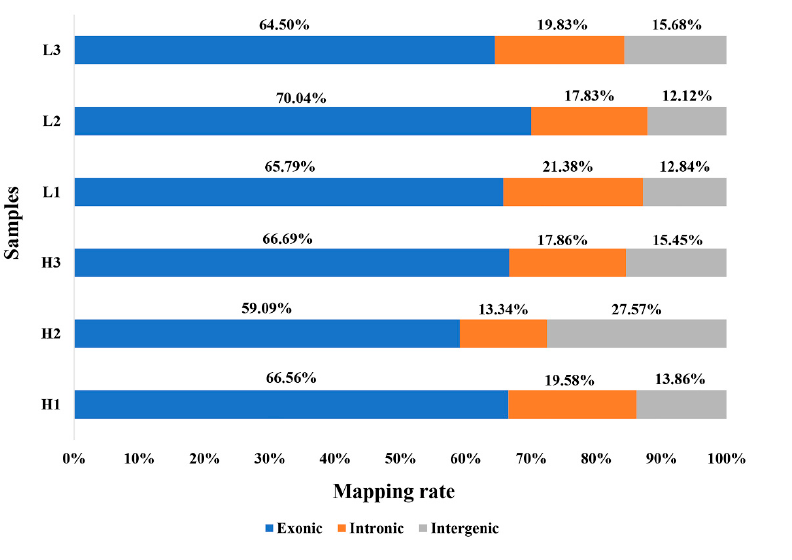
Figure 1. Percentage of reads mapped to exonic, intronic and intergenic regions of the referenced genome.